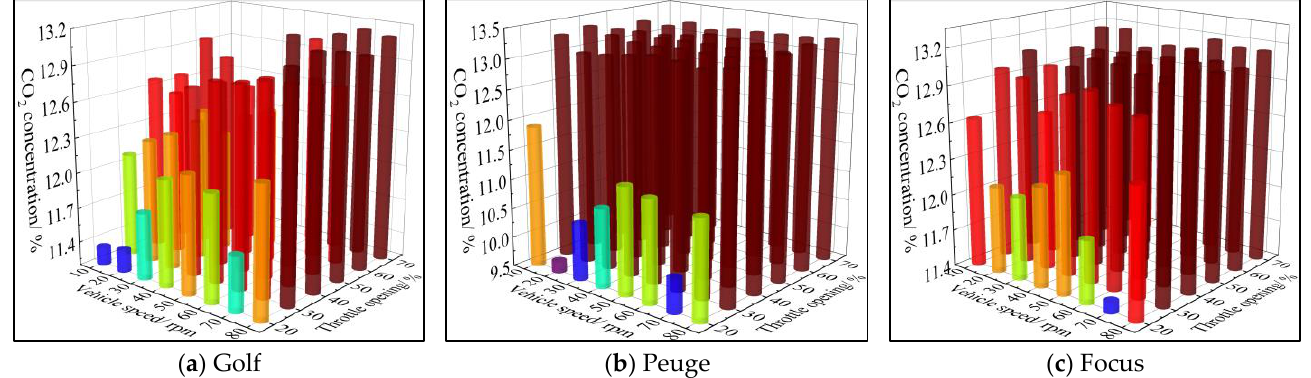
Figure 13. CO 2 concentration vs. vehicle speed and throttle opening.